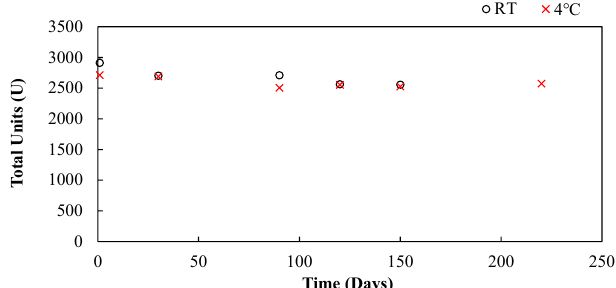
Figure 1. Urease activity measurements of jack bean crude extracts after storage of the whole beans at RT and 4 °C.